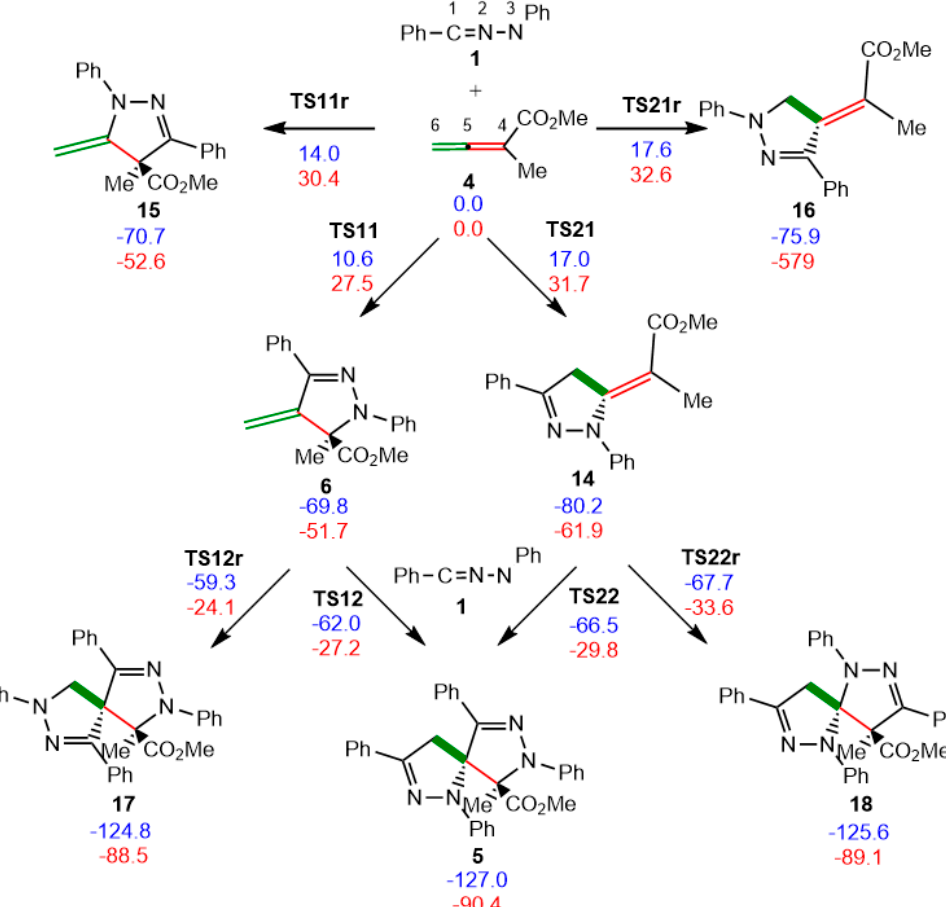
Scheme 5. Chemo- and regioisomeric reaction paths associated with the two consecutive 32CA reactions involved in the domino reaction of NI 1 with allenoate 4. MPWB1K/6-311G(d) relative enthalpies, in blue, and relative Gibbs free energies, in red, computed at 25 °C in dichloromethane (DCM) , are given in kcal·mol − 1